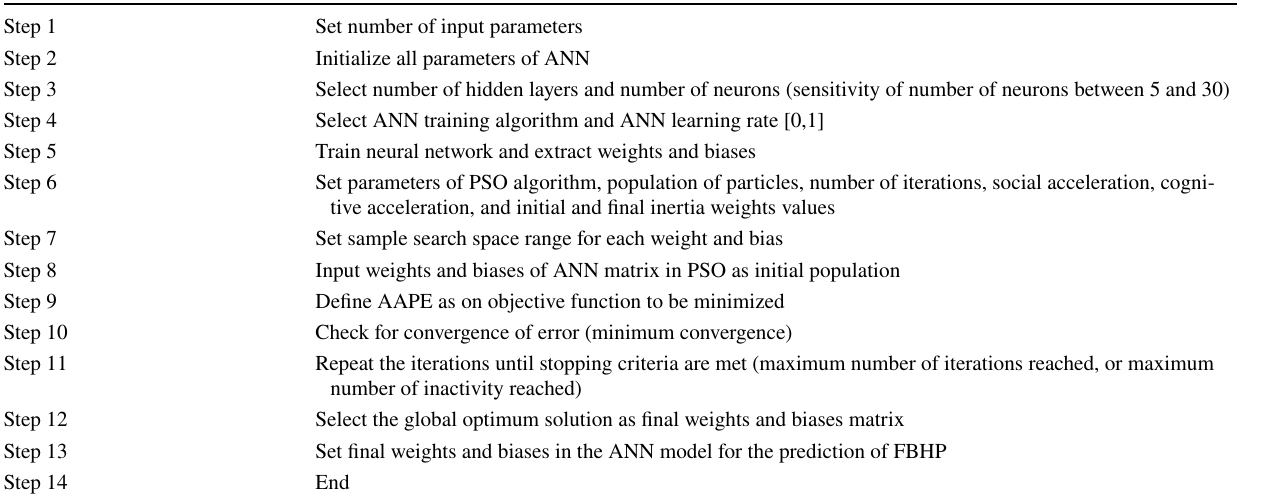
Table 3 Pseudocode for PSO-ANN